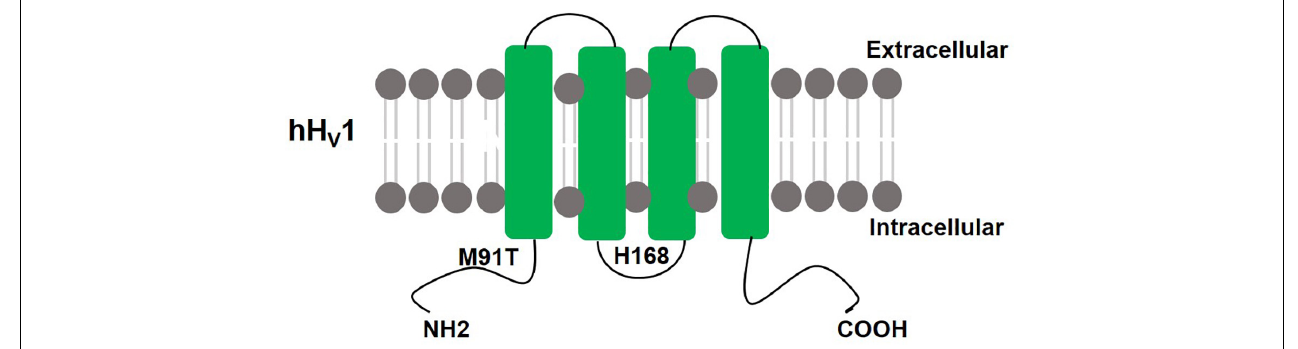
FIGURE 1 | Schematic structure of hHv1: hHv1 has four transmembrane domains with N terminus and C terminus lie inside the cells. H168 is crucial for (cid:49) pH-dependent gating, M91T mutant requires approximately 0.5 pH units more alkaline pH values than wild-type Hv1 to activate proton extrusion.